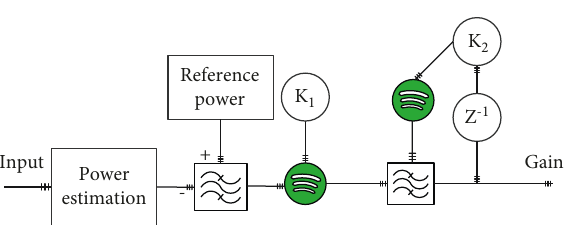
Figure 6: AGC based on average absolute error structure.